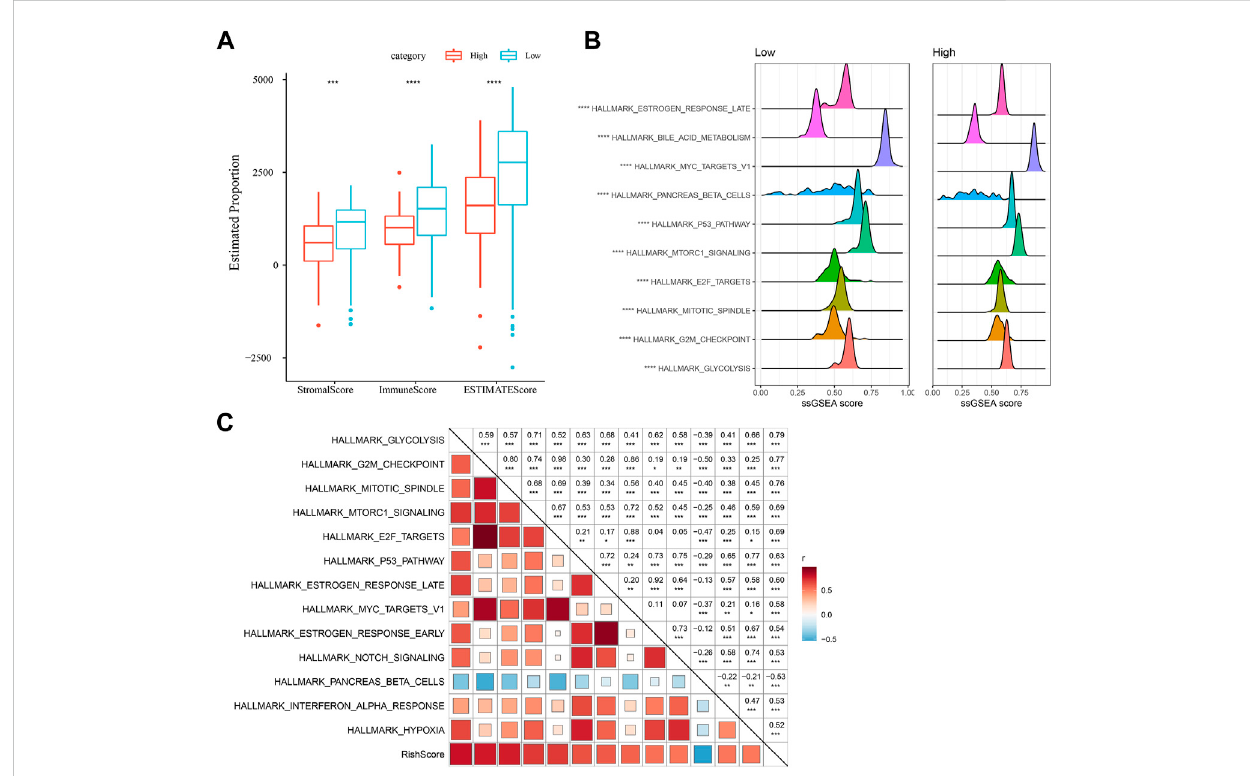
FIGURE 7 Immunology and pathway between different RiskScore subgroups. (A) ESTIMATE software was applied to determine immune cell components in theTCGAdatabase; (B) Thetop10pathwaysshowingthegreatestsigni fi cantdifferencesbetweenLow-riskandhigh-riskgroups; (C) Correlation analysis results on the RiskScore and KEGG pathways scored greater than 0.5; * p < 0.05; ** p < 0.01; * ** p < 0.001; and **** p <